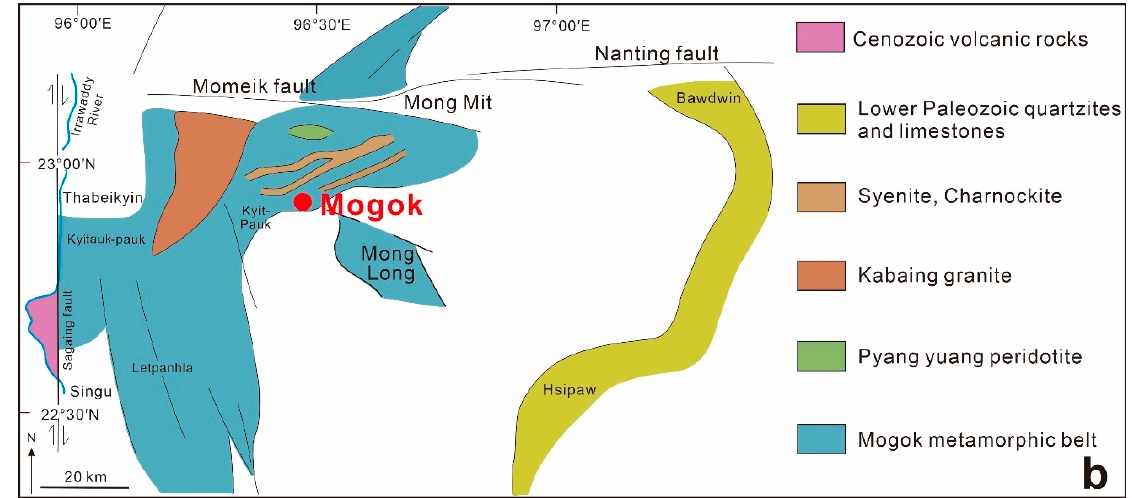
Figure 1. Geological maps of Mogok metamorphic belt and adjacent regions (modified from Win et al., 2018) ( a ) [42]. The main geological structures for the Mogok area (modified from Searle et al., 2020) ( b ) [39].